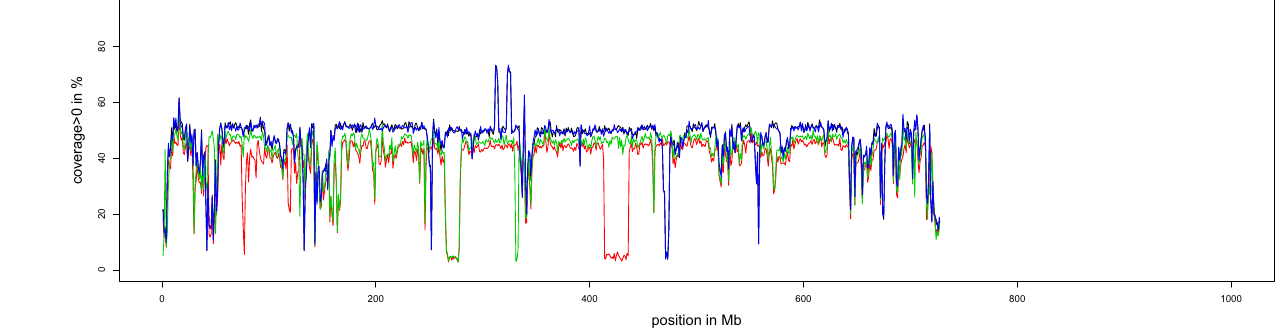
Figure 4. Difference in the coverage profile of chromosome 6B among four individual plants of cv. Krymka. Coverage profiles of the four plants are depicted in four colours (black, blue, red, and